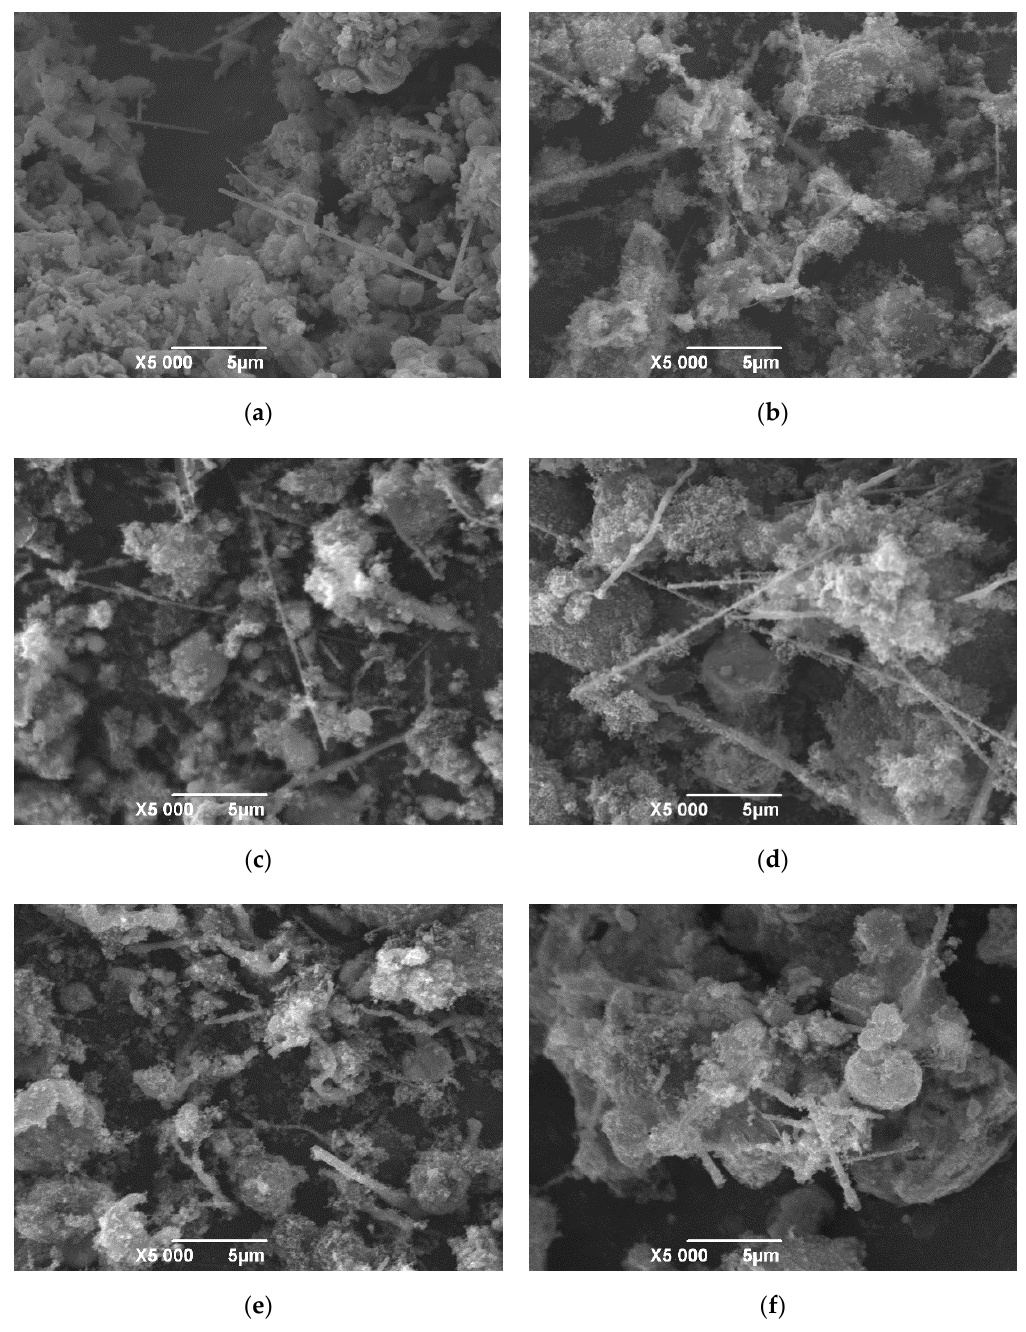
Figure 6. SEM images of samples at different processing conditions: ( a ) 1623 K, n(Fe):n(ZrSiO 4 ) = 0.2:1; ( b ) 1723 K, n(Fe):n(ZrSiO 4 ) = 0:1; ( c ) 1723 K, n(Fe):n(ZrSiO 4 ) = 0.1:1; ( d ) 1723 K, n(Fe):n(ZrSiO 4 ) = 0.2:1; ( e ) 1723 K, n(Fe):n(ZrSiO 4 ) = 0.3:1; (f) 1723 K, n(Fe):n(ZrSiO 4 ) = 0.4:1.